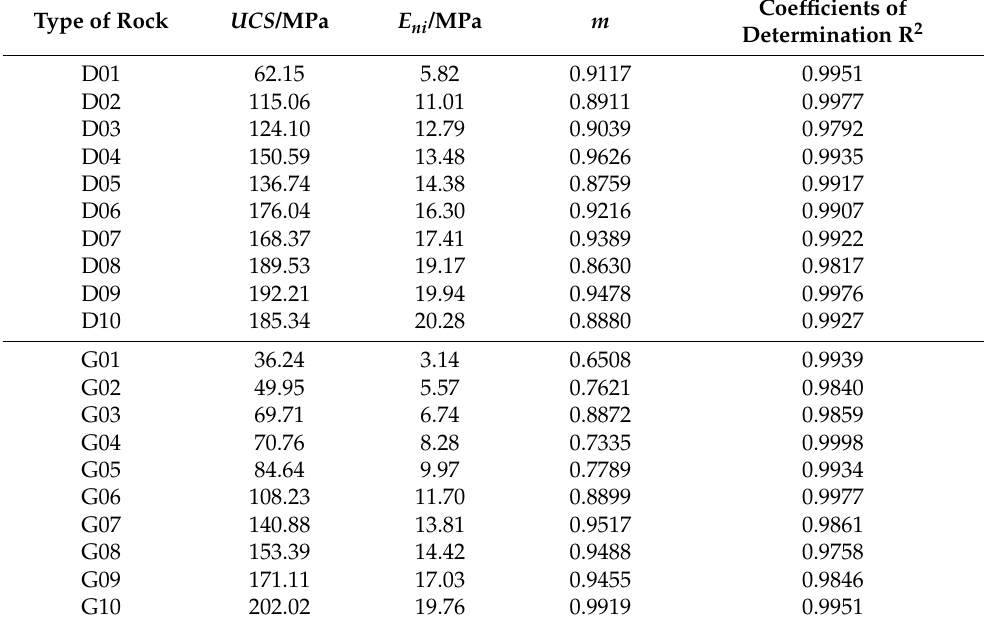
Table 1. Experimental and fitting results (D—Dolomite; G—Granite; L—Limestone;